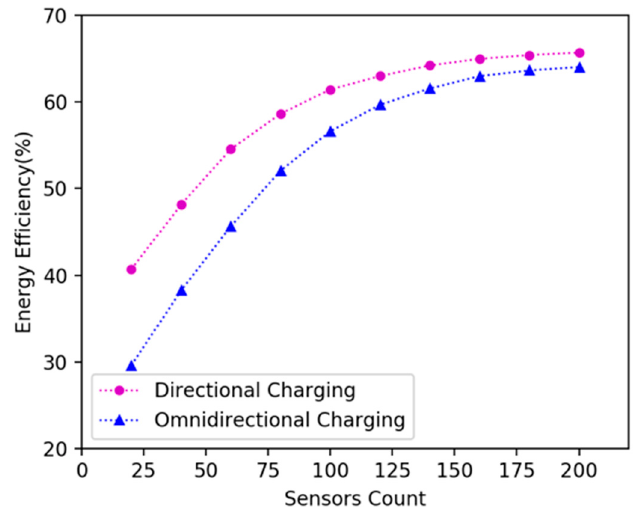
Figure 14. Energy e ffi ciency of the DCV and omnidirectional charging vehicle in 15 × 15 m 2 Figure 14. Energy efficiency of the DCV and omnidirectional charging vehicle in 15 × 15 m 2 area.